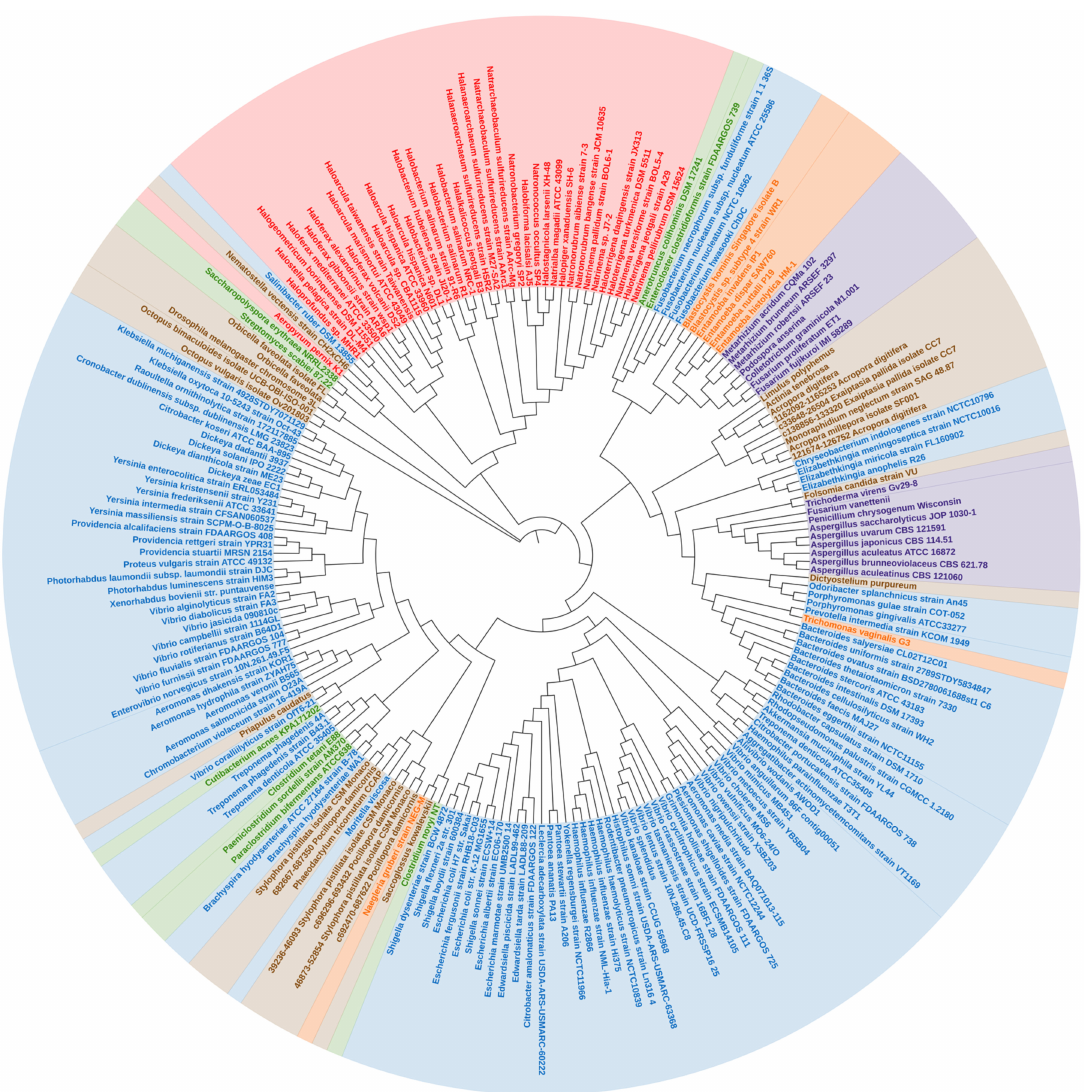
Figure 2. Amino acid sequence phylogenetic tree (arbitrarily rooted Maximum Likelihood tree) of the tnaA gene representing a total of 221 amino acid sequences belonging to 95 genera of various taxonomic groups. All the nodes represent bootstrap values ≥ 70 (1000 replications) and bootstrap value representation in Figure S2. Details of the phylogenetic analysis are provided in Methods. A complete list of genera and species and their taxonomic classifications are provided in Table 1. Species names are labelled according to phylogenetic classifications by the following colour codes. Gram-negative bacteria (blue), Gram-positive bacteria (green), archaea (red), fungi (purple), unicellular eukaryotes (orange), higher eukaryotes